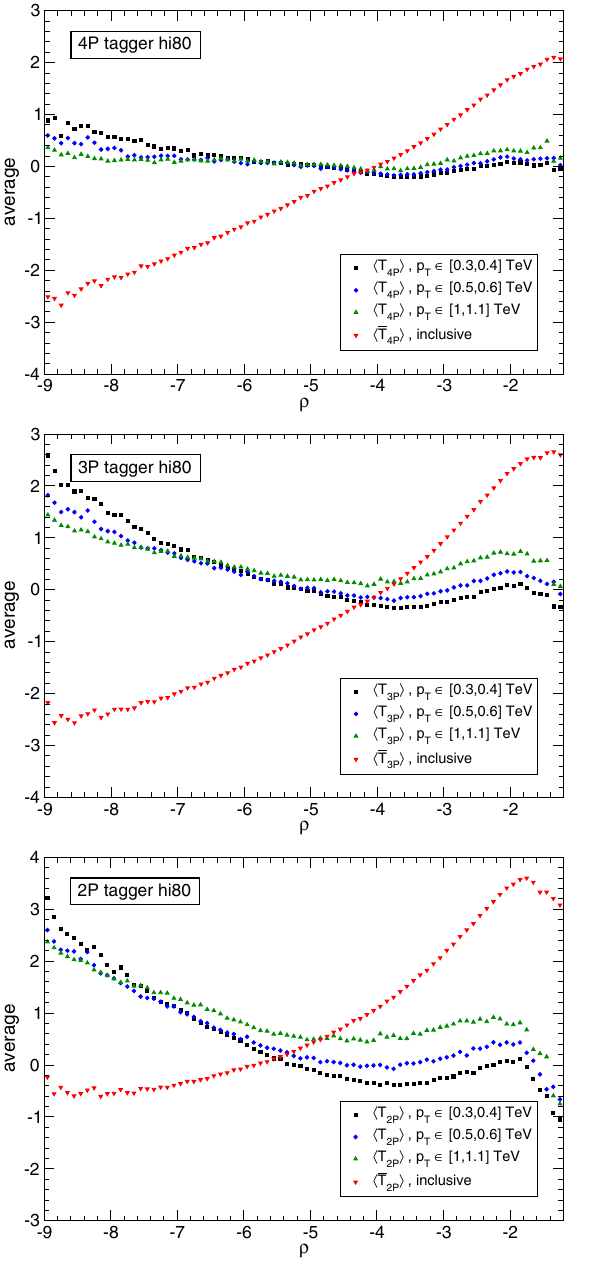
shown in red. Right: Jet mass distribution for the QCD background, after increasingly tighter cuts on the tagger output